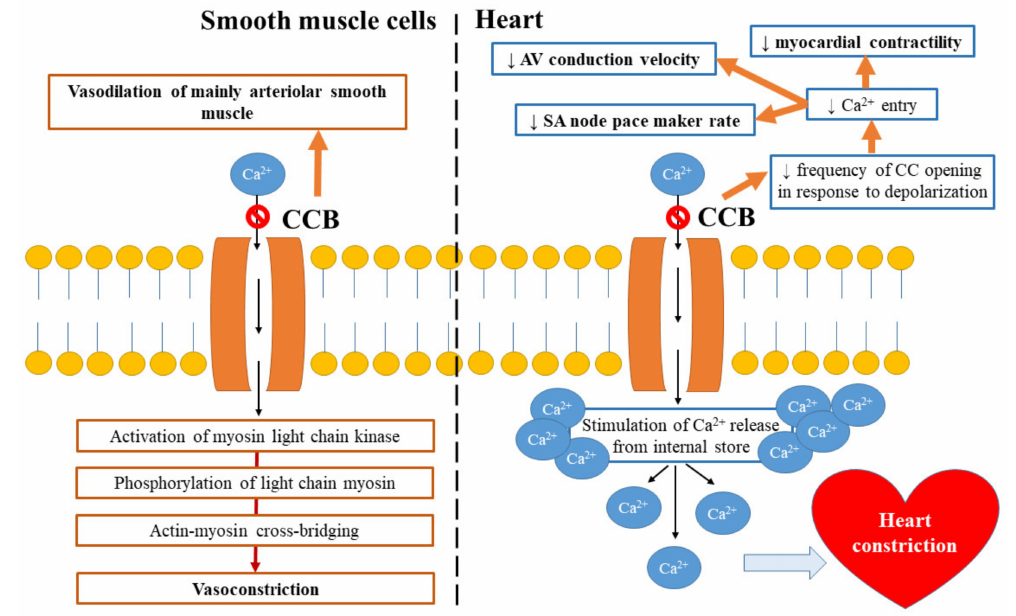
Figure 1. Mechanism of calcium channel blockers’ (CCBs)